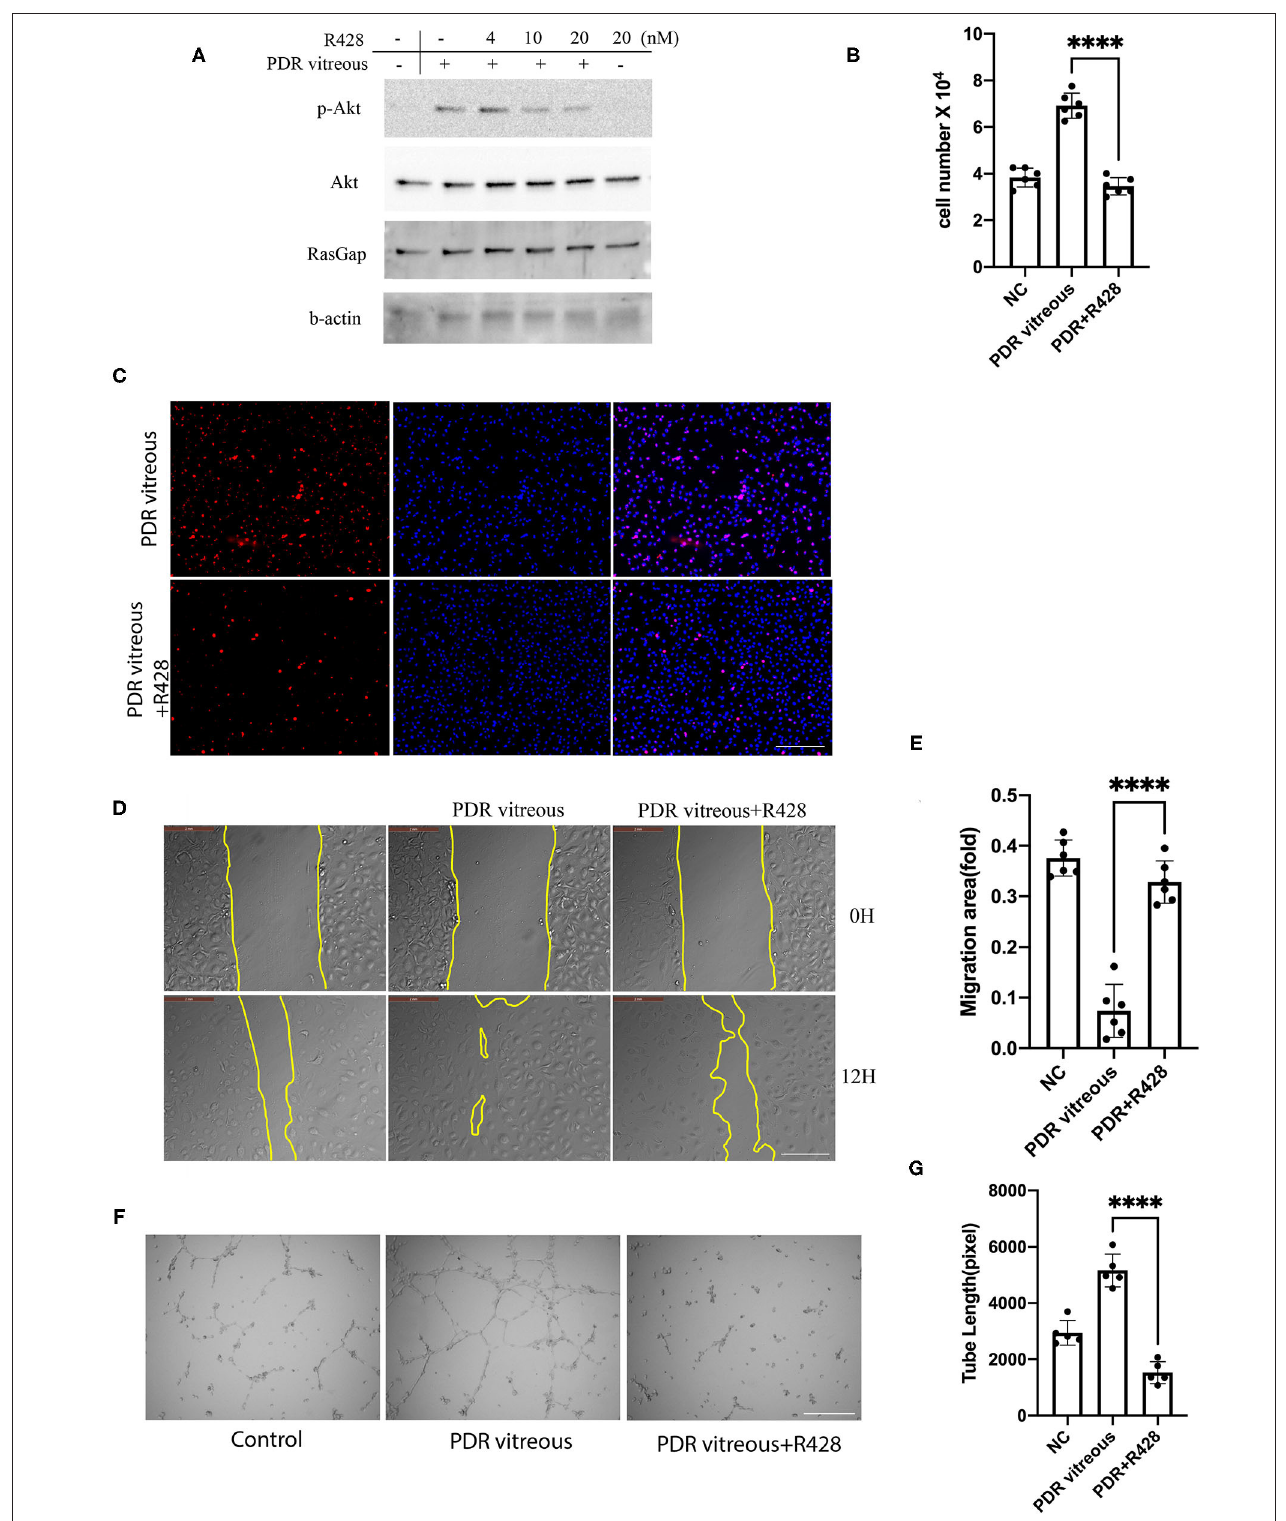
FIGURE 4 | Pharmacological inhibition of Axl blunted PDR vitreous-induced Akt activation, proliferation, migration, and tube formation. (A) Western blot analysis of p-Akt in HRECs treated with PDR vitreous and a serial of R428 (an Axl-specific inhibitor) concentrations using indicated antibodies. This is representative of three independent experiments. (B,C) Proliferation of HRECs induced with PDR vitreous supplemented with R428 (4 µ M) was evaluated by counting cell number (B) and